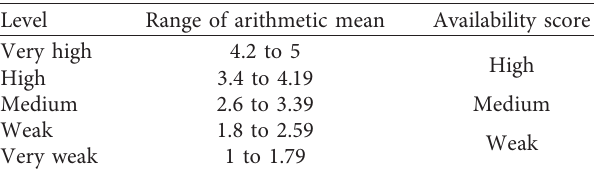
Table 4: Distribution of the level of availability score for the arithmetic mean.